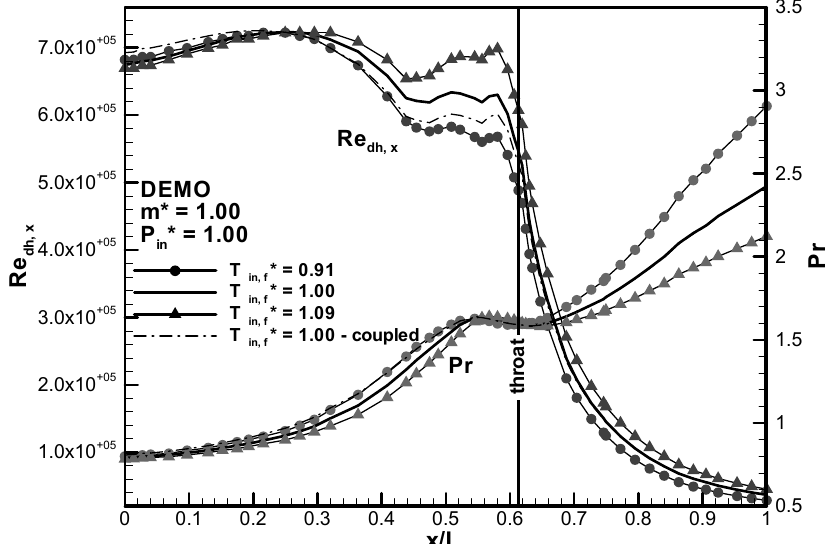
Figure 12. Axial profiles of Reynolds number and Prandtl number, considering different values of inlet fluid temperature (runs 1-4).